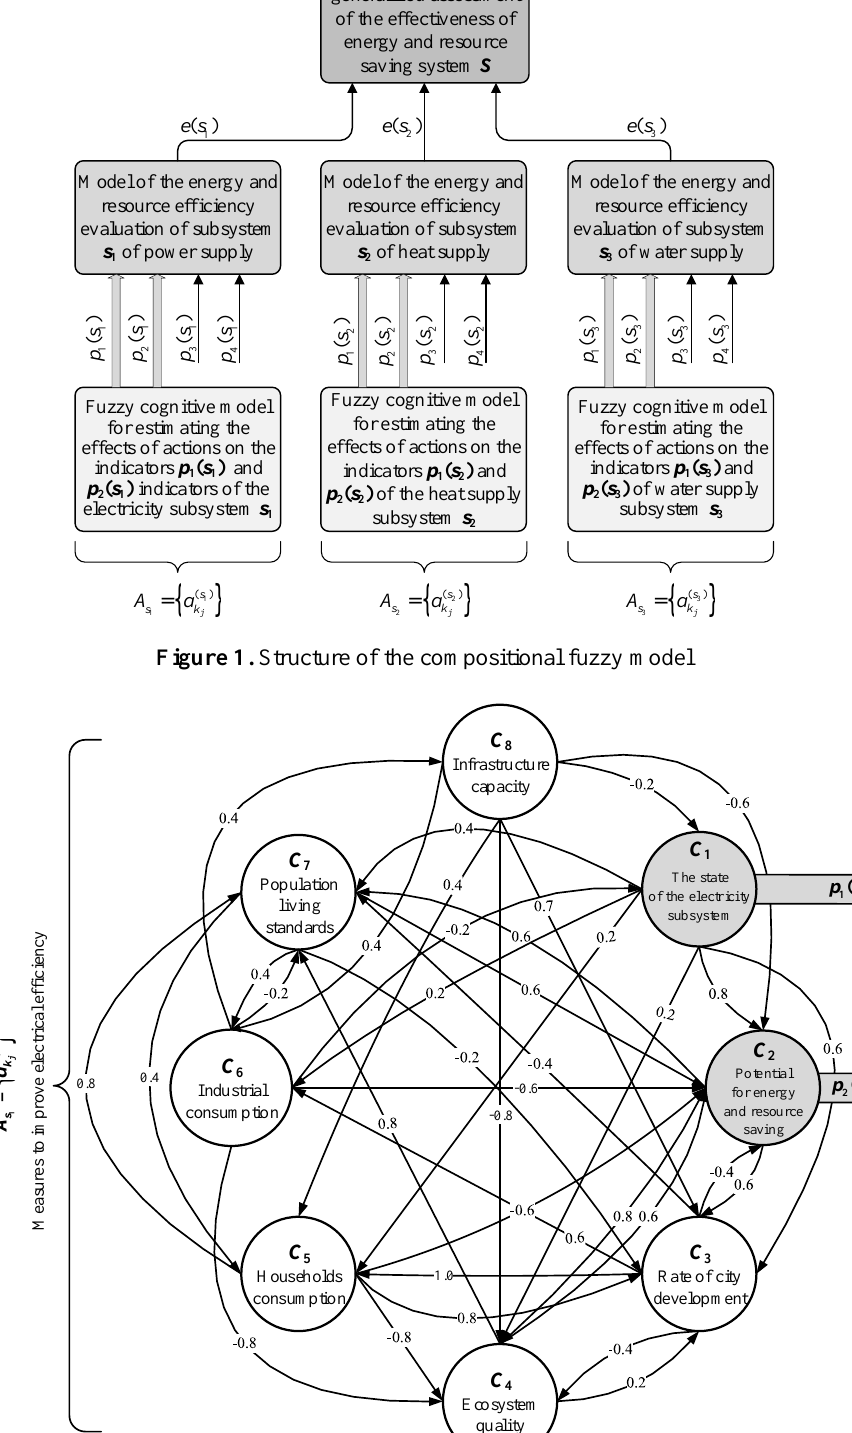
Figure 2. Fuzzy cognitive model for estimating the impact of